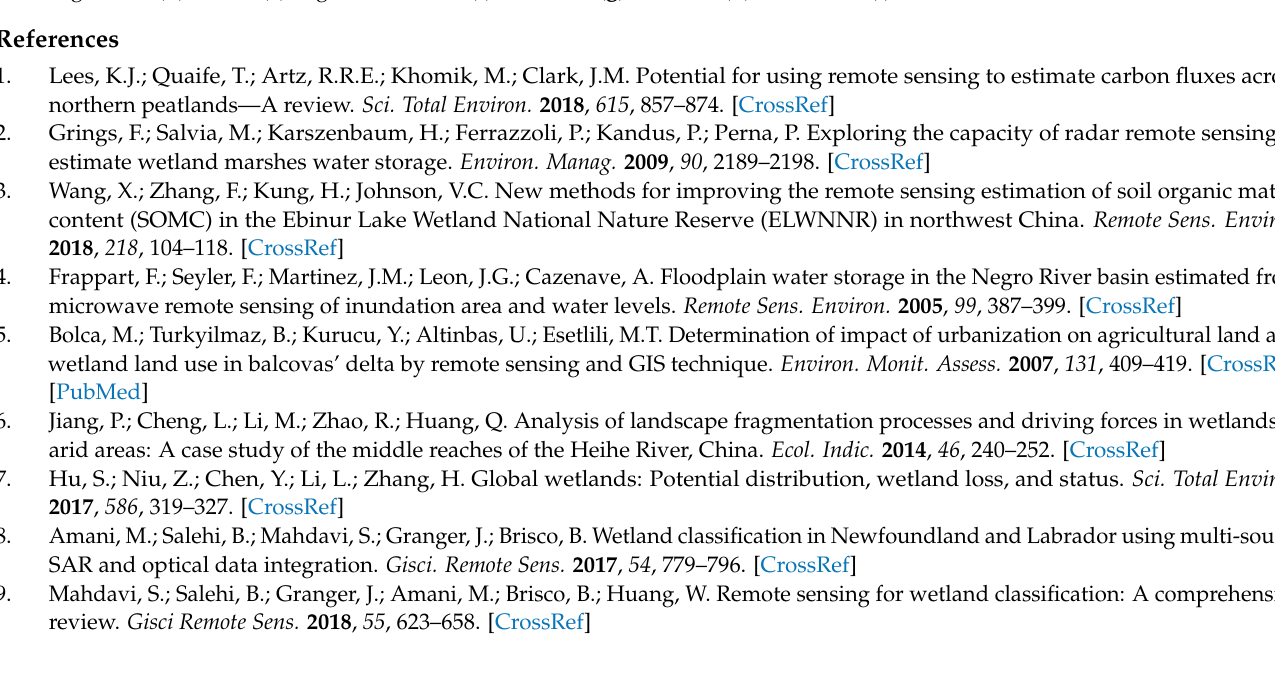
Figure A6. The mean Spectral signature of Phragmites australis ( a ), Juncus acutus ( b ), Typa angustifolia ( c ), Non-wetalnd vegetation ( d ), Water ( e ), Agriculture land ( f ), Bareland ( g ), Mudflat ( h ) and Urban ( i ).